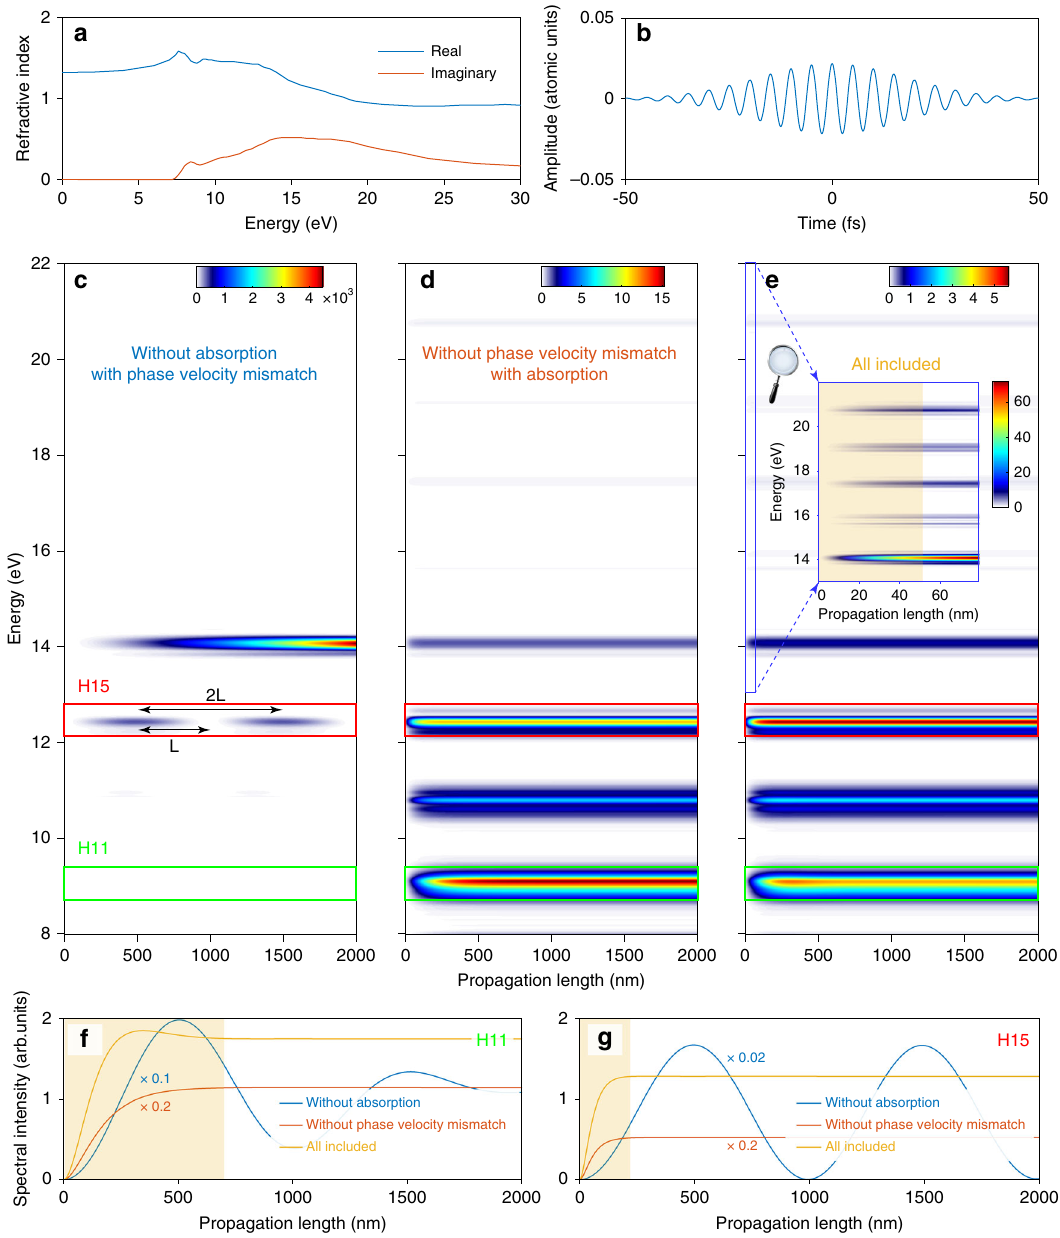
Fig. 8 Propagation and phase-matching effects in liquid water obtained by solving the coupled Maxwell – semiconductor Bloch equations. a Complex refractive index 26 and b , electric fi eld utilized in our simulations. c – e Spectral intensity build-up at different positions inside the liquid water fl at microjet for three cases: c , keeping only the real part of the refractive index, while setting the imaginary part to zero; d keeping only the imaginary part of the refractive index while setting the real part to one; e using the complete complex refractive index. f , g Spectral intensity of H11 and H15 integrated over the vertical dimension of the rectangles in c – e . Their absolute intensities are scaled as indicated. The orange rectangles in e – g highlight the build-up length of the HHG interferometry to measure the thickness of our fl at microjet. The thickness is in the chamber displays a pressure of ≈ 1× 10 − 3 mbar maintained by two liquid-nitrogen range of ~1.2 – 1.9 μ m depending on the fl ow rate, type of liquid, and position of the cold traps, while the spectrometer has a pressure of ≈ 1 ×10 − 5 mbar. measurement with respect to the fl at microjet. The fl ow rate for the creation of a The generated EUV spectra are recorded using a spectrometer consisting of a stable fl at microjet in turn depends on the nozzle size and the viscosity of the fl at- fi eld abberation-corrected grating (300grooves/mm, Shimadzu), a sample, which is in the range of 2ml/min for alcohols and up to 6ml/min for multichannel-plate detector coupled to a phosphor screen, and a charge-coupled liquid water. Under the chosen fl ow rates and nozzle sizes, the speed of the liquid device camera. All spectra reported in the main text are corrected for grating ef fi ciency, multichannel-plate response, and conversion from wavelength to frequency domain. Flat – microjet apparatus: We developed our own fl at-microjet system with inspiration from the commercially available system 24 . The liquid sample is pumped samples in our experiments. with a high-performance liquid chromatography (HPLC) pump through two It has been shown in ref. 59 that micro – droplets and small bubbles are produced cylindrical nozzles, creating two colliding microjets. For all experimental results upon interaction of intense laser pulses with liquids. The extreme energy of the presented in this paper two ≈ 50 μ m nozzles have been used. We used white light